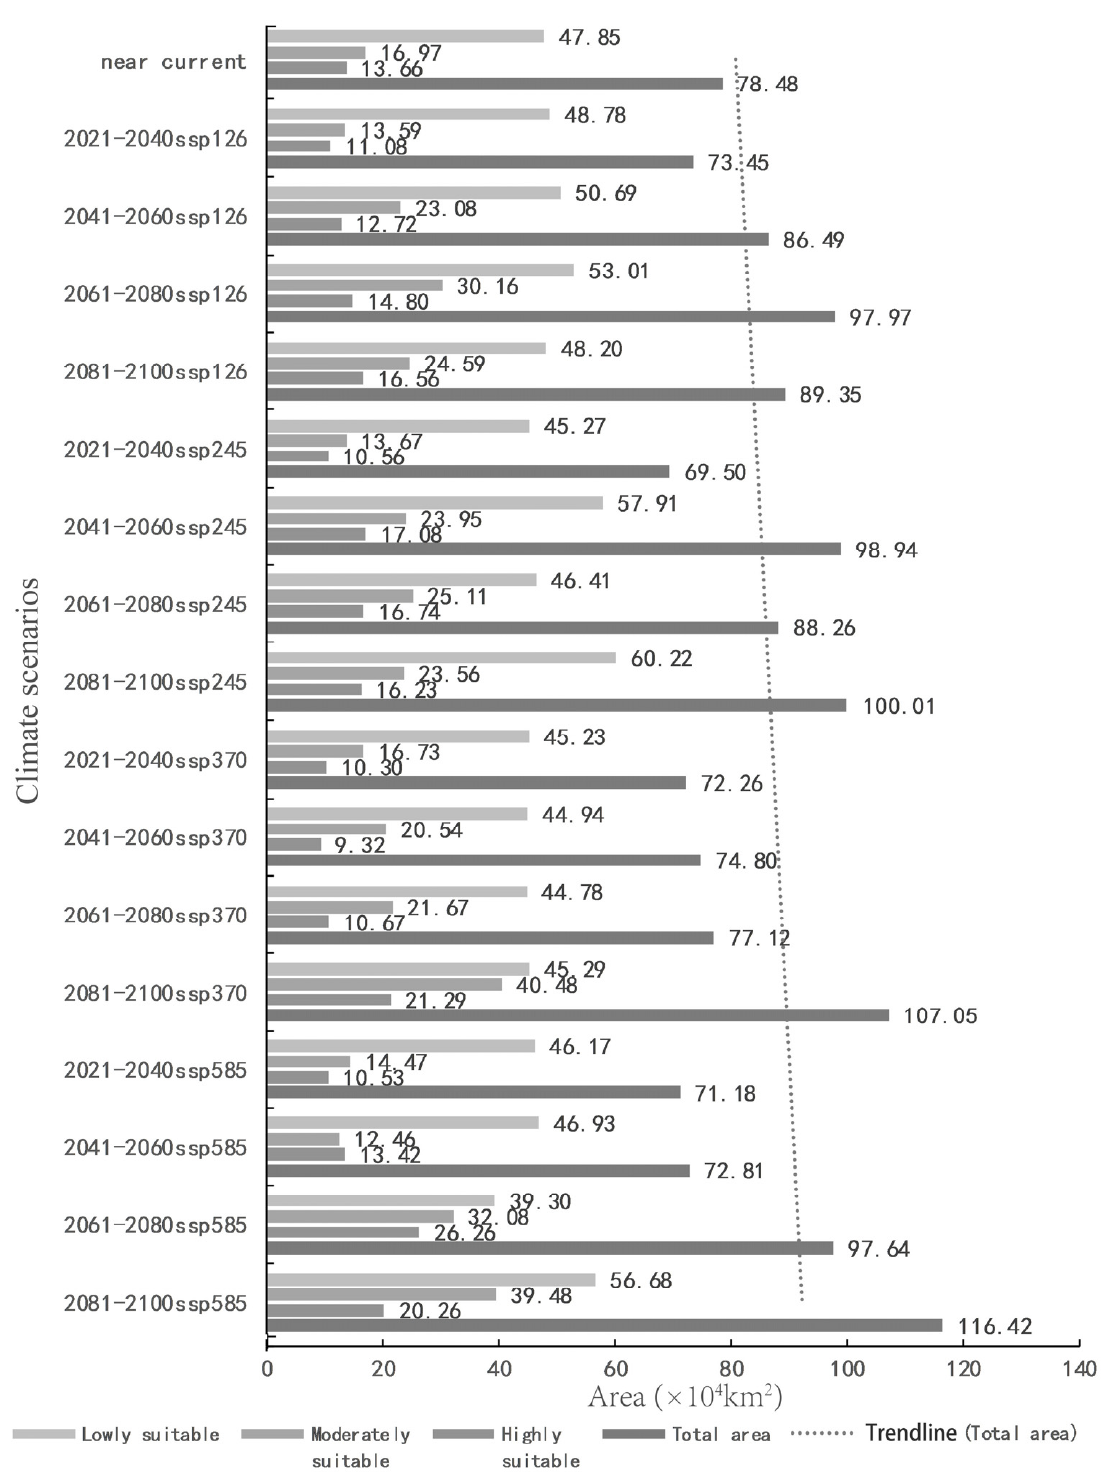
Figure 4. Change trend of potentially suitable areas for Anopheles philippinensis in China under near-current and future climate conditions.